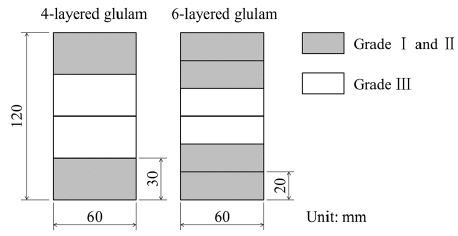
Figure 2. Cross ‐ section of the glulam specimens. Figure 2. Cross-section of the glulam specimens.